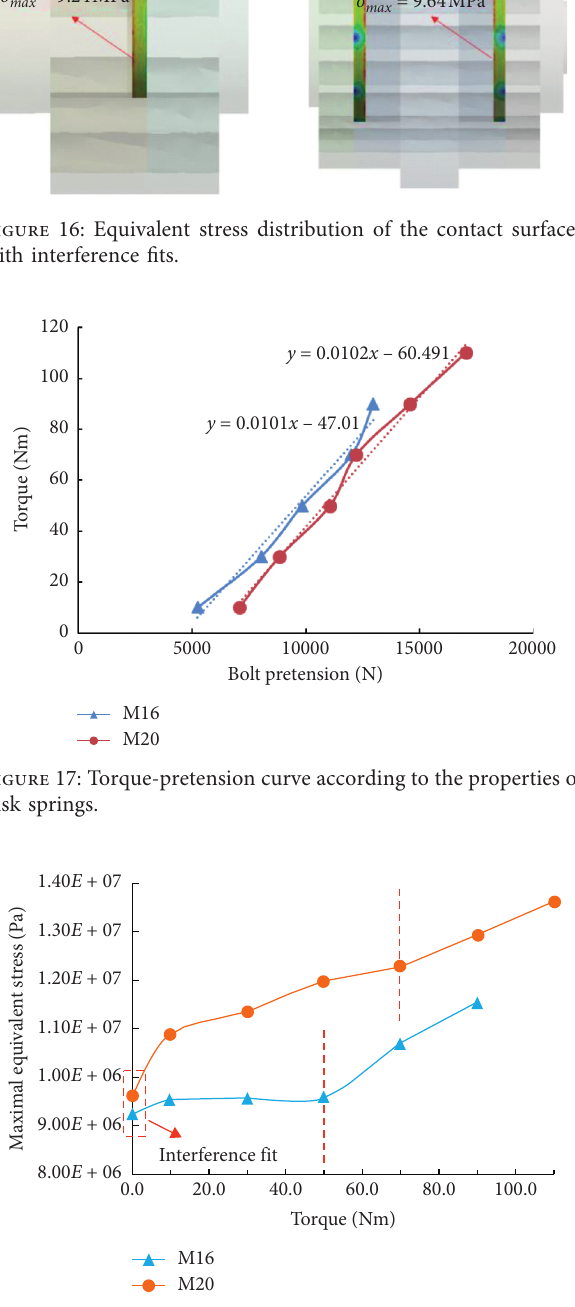
Figure 18: Maximal equivalent stress considering the interference fits and the preload. Table 3: Sensitivity of the natural frequency with respect to the contact stiffness for modes